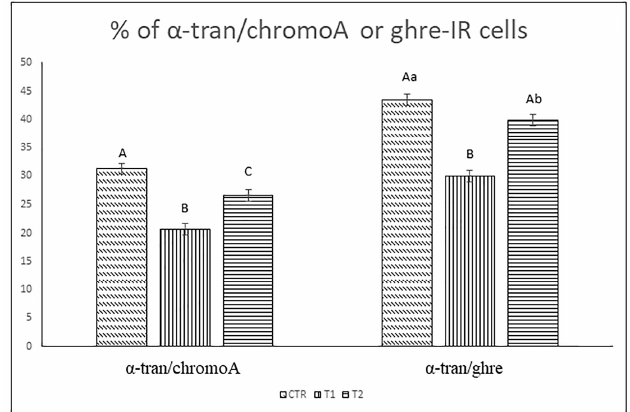
Figure 6. Percentage of α -tran/chromoA or ghre-IR cells. The values are shown with different superscripts (a, b) for p < 0.05 and (A, B) for p < 0.01.